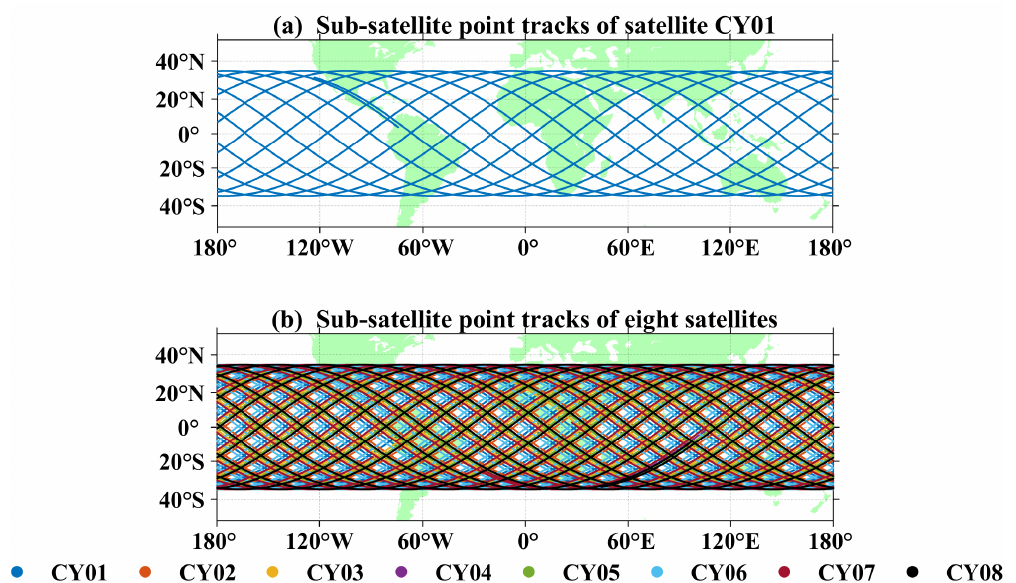
Figure 1. Tracks of one and eight CYGNSS sub-satellites. ( a ) Sub-satellite point tracks of one cyclone global navigation satellite system (CYGNSS) satellite for 24 hours; ( b ) sub-satellite point tracks of eight CYGNSS satellites for 24